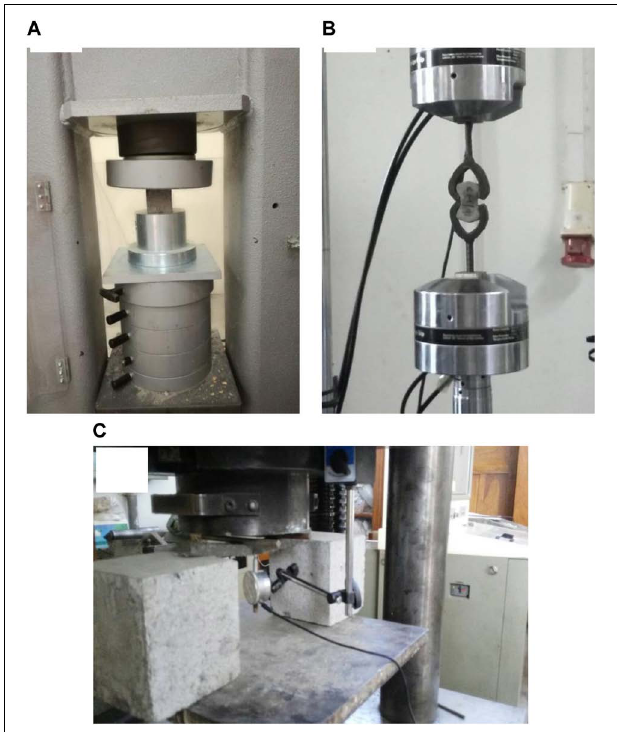
FIGURE 5 | Test setup to measure: (A) compressive strength, (B) tensile strength, and (C) flexural strength of the ECCs.